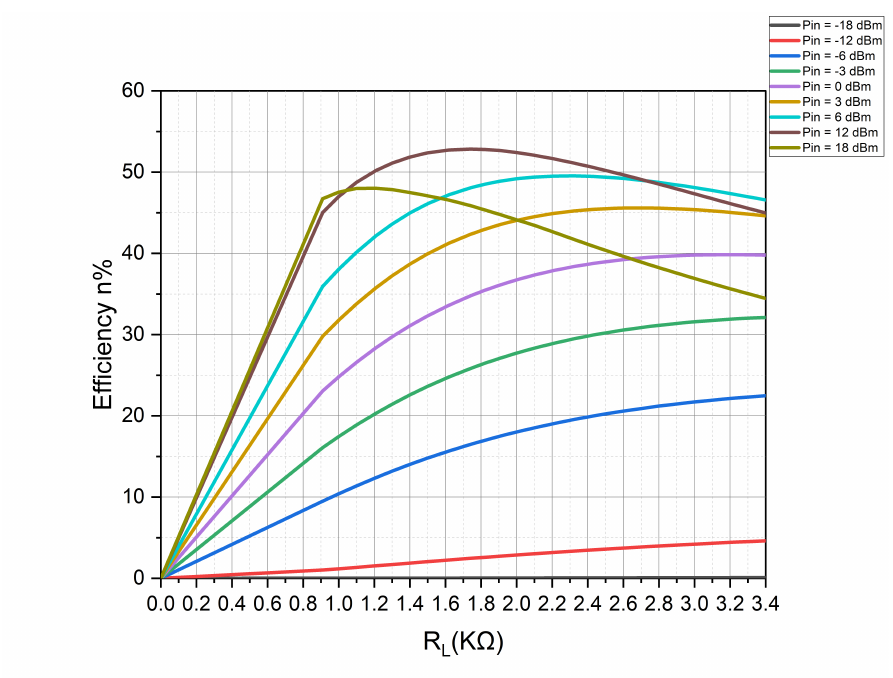
Figure 7. Power conversion efficiency versus the output load R L .